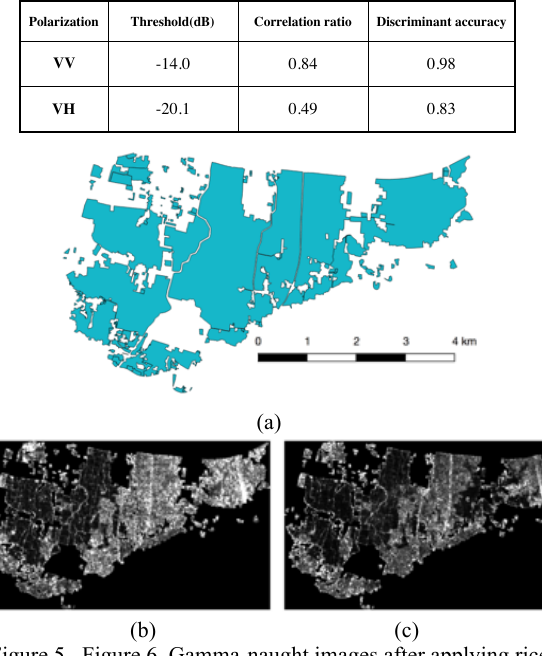
Figure 6. Extracted flooded area from SAR data. Black area indicates the rice paddy fields where the backscattering is decreased from Feb.17 to